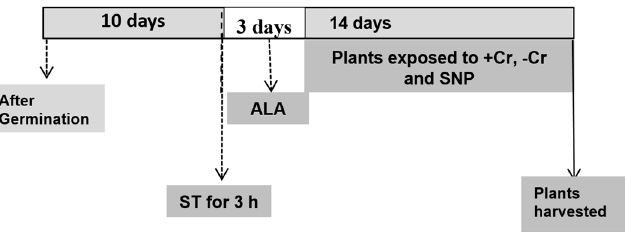
Figure 8. An outline of the experimental design showing that 10-day-old tomato seedlings were treated for 3 h with 0.1 mM sodium tungstate (ST) before the application of 20 mg L − 1 5-aminolevulinic acid (5-ALA) for 3 days. Different chemicals were applied to examine the effect of 5-ALA, with or without chromium (Cr) treatment, on tomato seedlings. The concentrations used were 20 mg L − 1 5-aminolevulinic acid (5-ALA), 50 µ M Cr(VI), 0.1 mM sodium nitroprusside (SNP, a donor of NO), and 0.1 mM sodium tungstate (ST, an inhibitor of nitrate reductase; NR, an enzyme that catalyzes NO formation). Chromium (Cr) was applied for 14 days on 13-day-old tomato seedlings. At the end of the experiment, tomato seedlings were 27 days old.